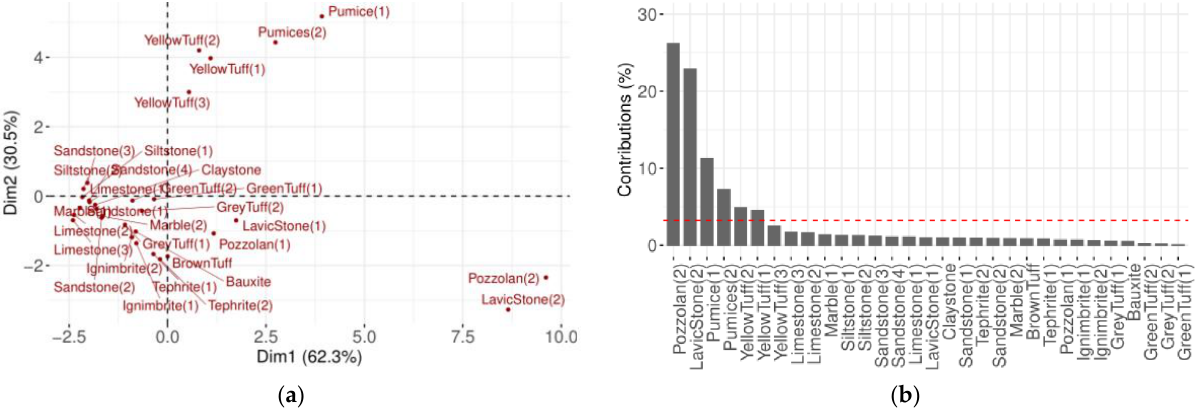
Figure 3. ( a ) Representation of all Campania building materials in the plan of the two main compo- nents identified. ( b ) The percentage contribution of each material (individual) to the two main com- ponents.